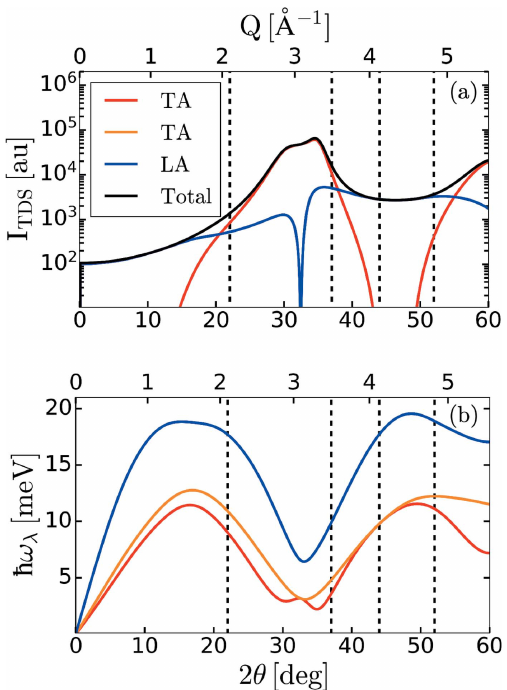
Figure 4 ( a ) Thermal diffuse scattering intensity calculated for gold, I TDS , as a function of the angular offset from the direct X-ray beam in the equatorial plane, 2 (cid:8) . ( b ) Corresponding phonon dispersion relation. Blue corresponds to the longitudinal acoustic (LA) mode, orange and red correspond to the transverse acoustic (TA) modes. The solid black line in ( a ) corresponds to the summation over all the branches. The dashed vertical black lines in ( a ) and ( b ) represent the angular offset for the analysers used in the discussed